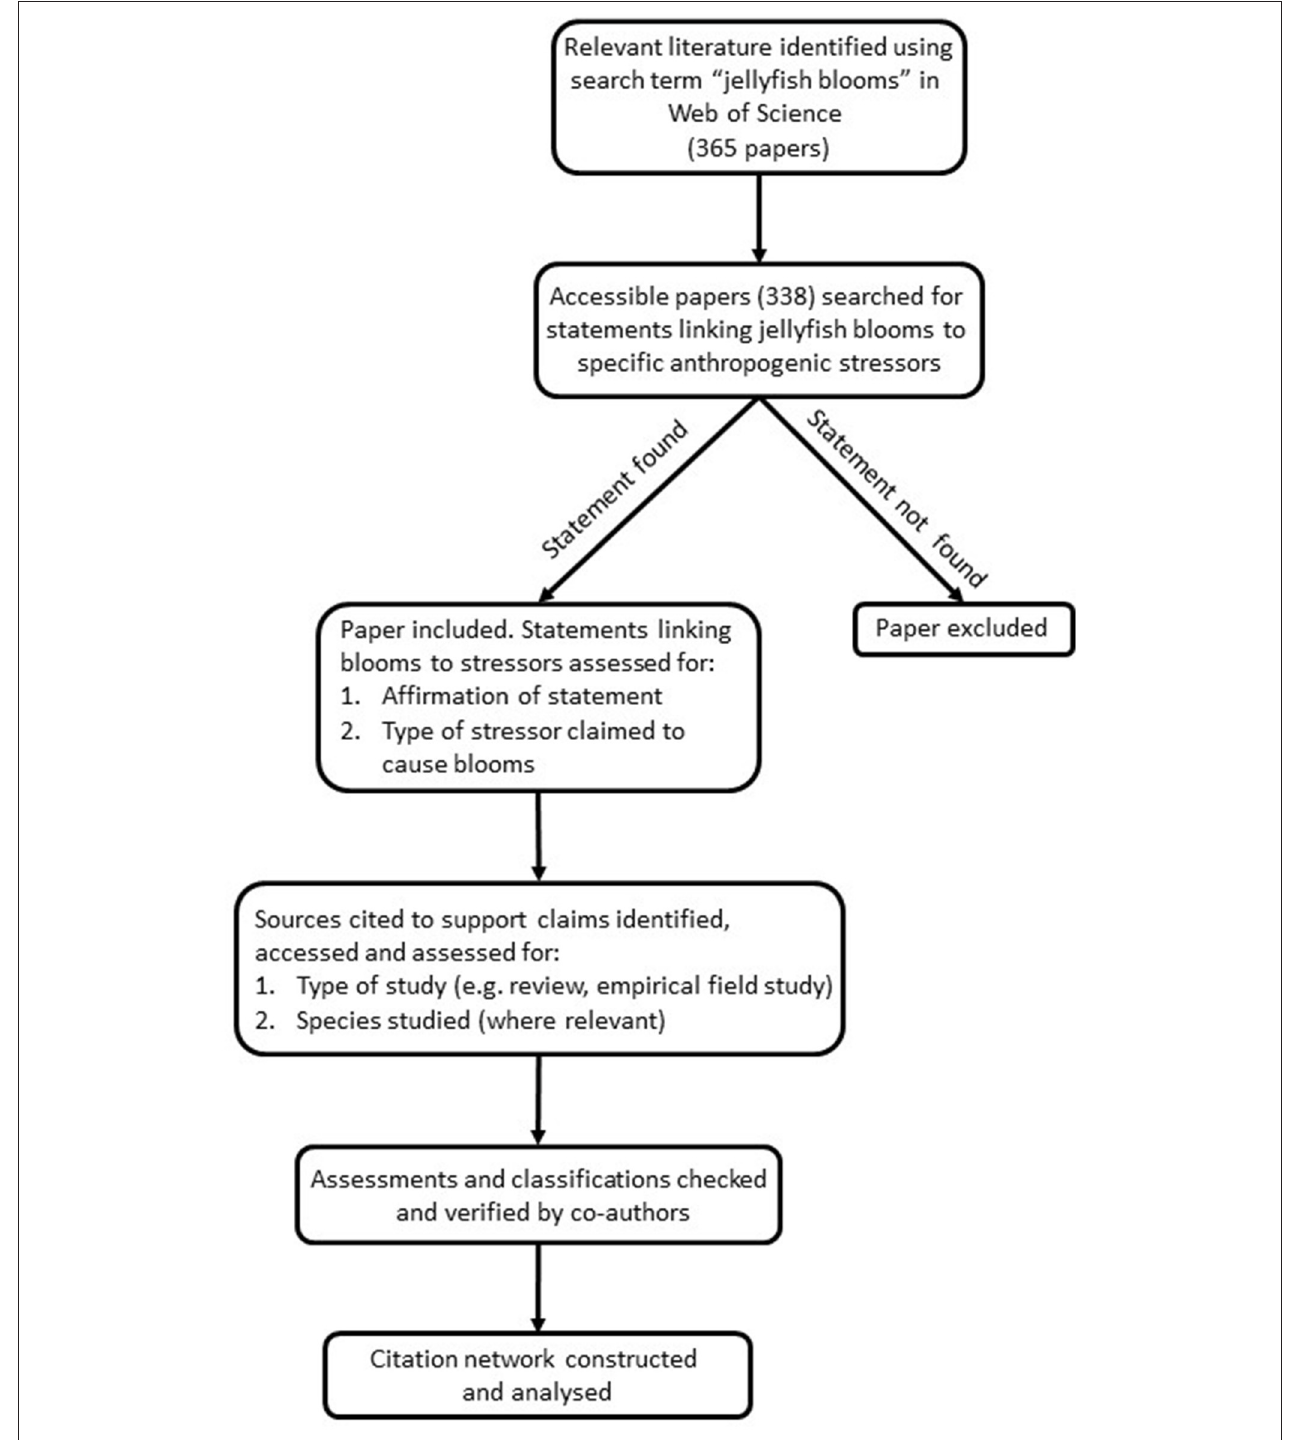
FIGURE 1 | Flow diagram of the methodology used to select and assess papers in this systematic review. 2011) were not, because such statements did not specifically state that the changing conditions were anthropogenic. A list of papers used in the network is provided in Tables S1, S2